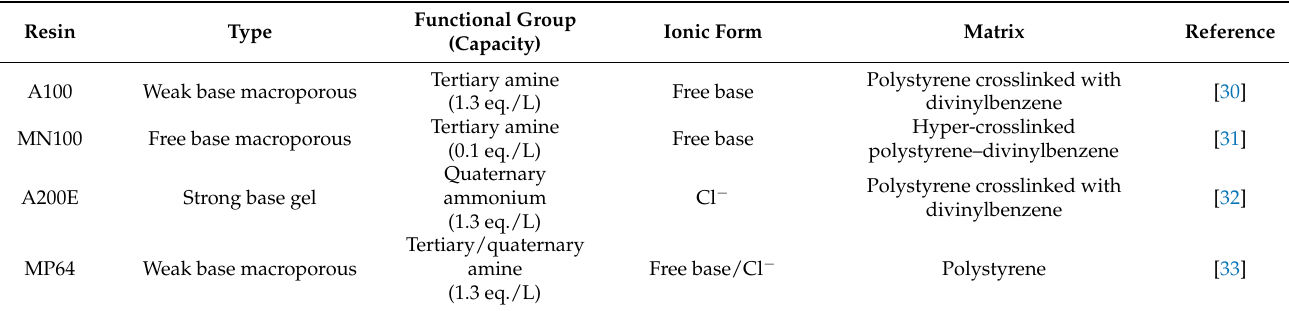
Table 1. Resins properties tested in this